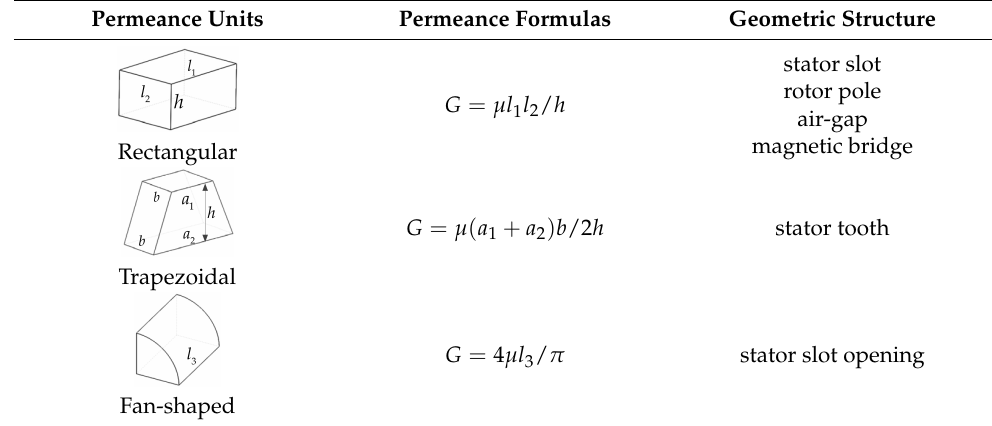
Figure 3. The finite element model of the IPMSM. ( a ) End view drawing; ( b ) grid diagram; ( c ) the basic modeling process. Table 1. The types of finite